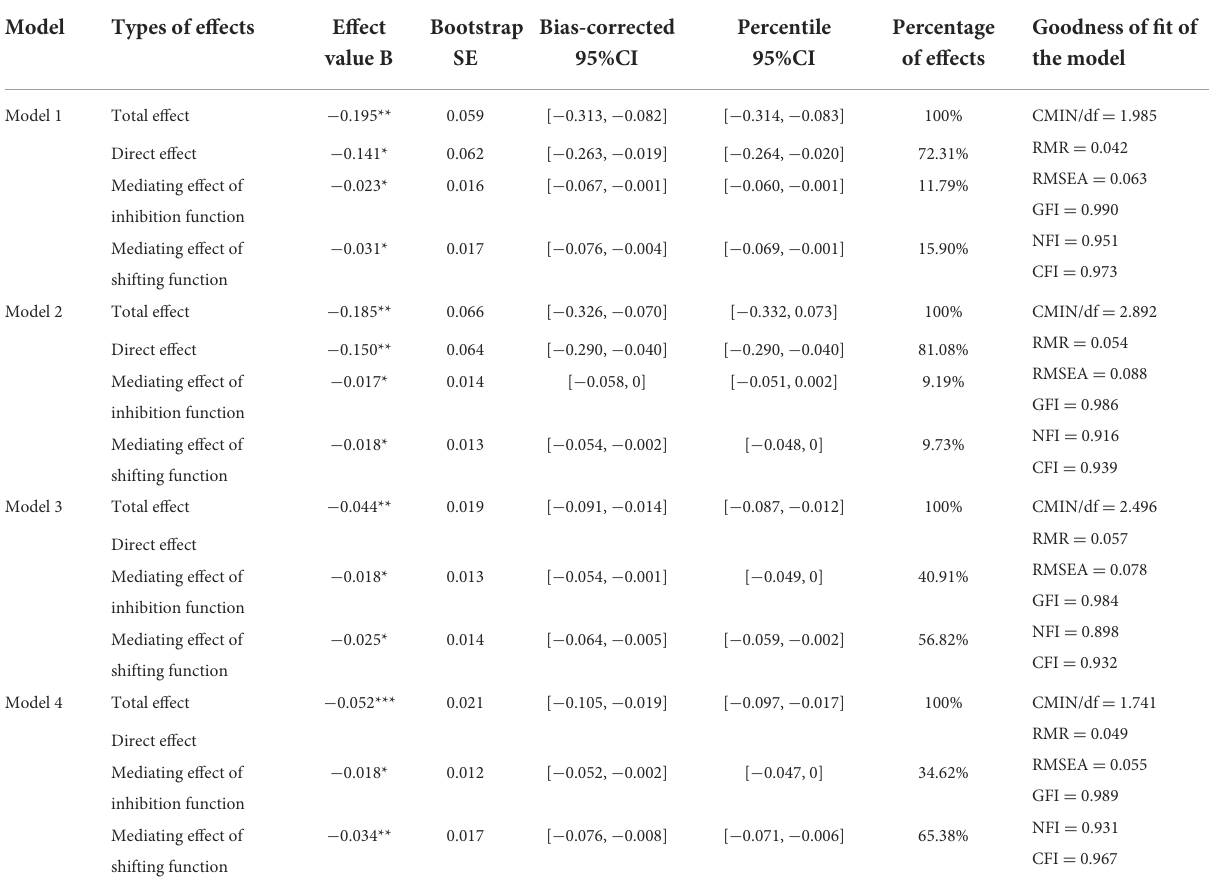
TABLE 3 Results of bootstrap test for mediating